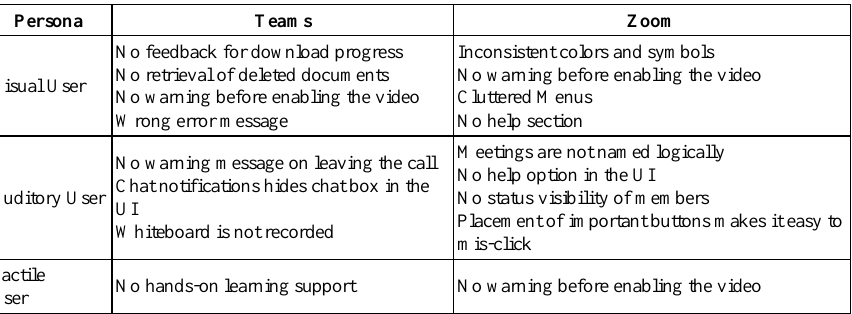
Table 6. Unmet user needs factored by user persona